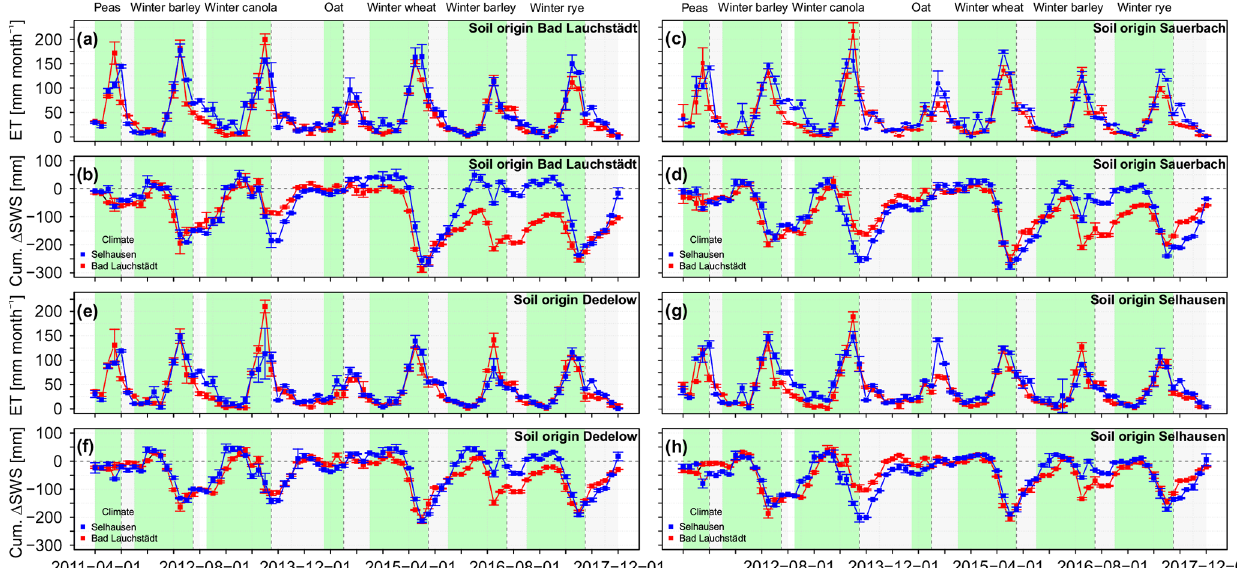
Figure 2. Monthly evapotranspiration (ET) and cumulative monthly changes in soil water storage ( (cid:49) SWS) from April 2011 until Jan- uary 2018 at the lysimeter stations in Selhausen and in Bad Lauchstädt for soils from Bad Lauchstädt (a, b) , Sauerbach (c, d) , Dedelow (e, f) and Selhausen (g, h) ; mean values (dots) and standard deviations (error bars) are from three individual lysimeter monoliths of each soil. The background colour corresponds with the cropping periods at the TERENO-SOILCan lysimeters: bare soil (white) and crops (green). Dates are given in the figure in the YYYY-MM-DD format.